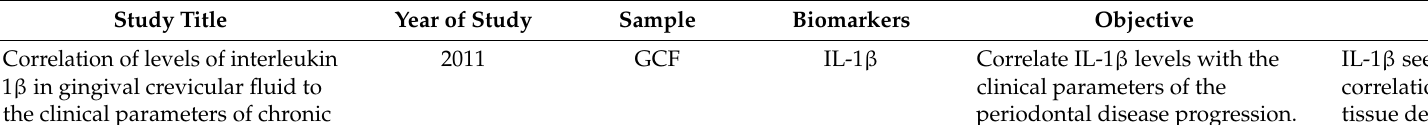
Table 1. Studies showing GCF as biomarkers for periodontal health and